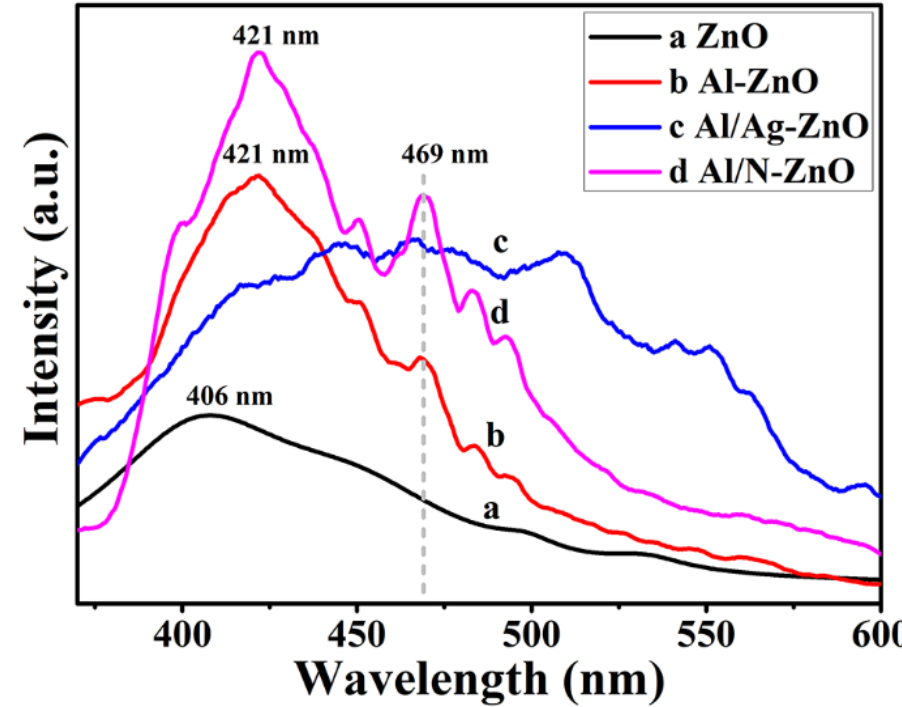
Figure 7. PL spectra of ZnO (a), metal single doping ZnO (Al-ZnO) (b), metal/metal co-doping ZnO (Al/Ag-ZnO) (c), and metal/non-metal co-doping ZnO (Al/N-ZnO) (d). In this work, the violet peak of ZnO has a redshift to the blue band after metal Al single doping ZnO, which is considered to be related to the change of ZnO bandgap. At the same time, the intensity of the blue emission rapidly increases after Al and N co-doping, and sharp quenching in the case of Al and Ag co-doping. Both metal/metal and metal/non- metal co-doping are highly non-equilibrium processes. Generally, a large number of defects will occur, and interstitial zinc defects are dominant in the as-prepared ZnO films. In addition, among the four samples, the bandgap of Al/N-ZnO is the smallest, which makes the optical transition easier, so the optical properties of ZnO are also